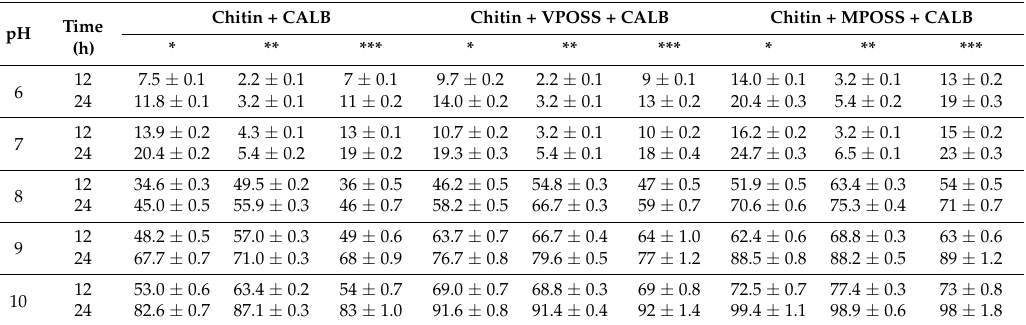
Table 3. Effect of the pH and reaction time on the chemical composition, * relative content of FAME (%), ** relative content of glycerol (% w / w ), and *** conversion (%) after methanolysis of rapeseed oil. As the relative content, the measured mass of the substance to theoretical mass of the substance after total methanolysis is considered. Reaction conditions: 7.5 cm 3 rapeseed oil, 1.5 cm 3 methanol, 10 mg of the immobilized lipase, T = 40 ◦ C.